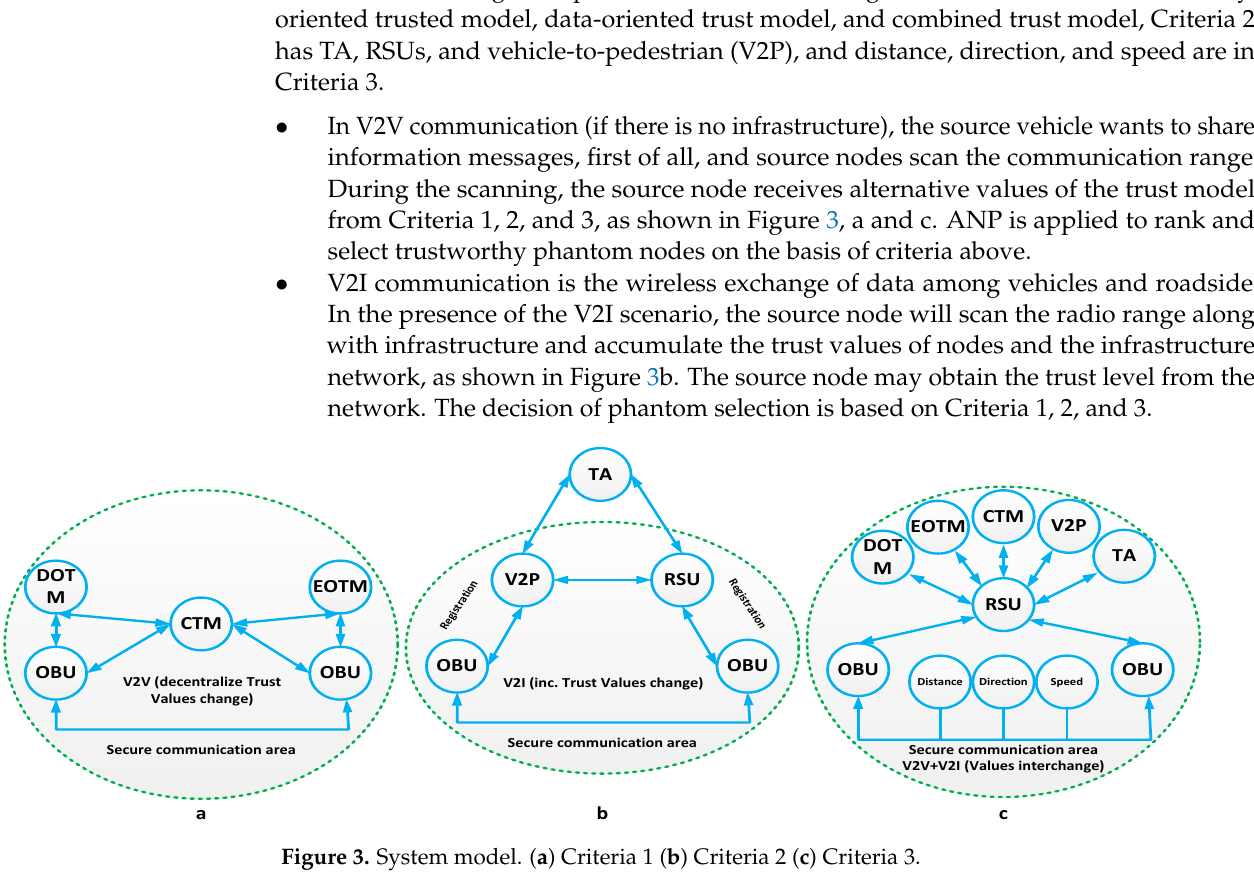
Figure 3. System model. ( a ) Criteria 1 ( b ) Criteria 2 ( c ) Criteria 3